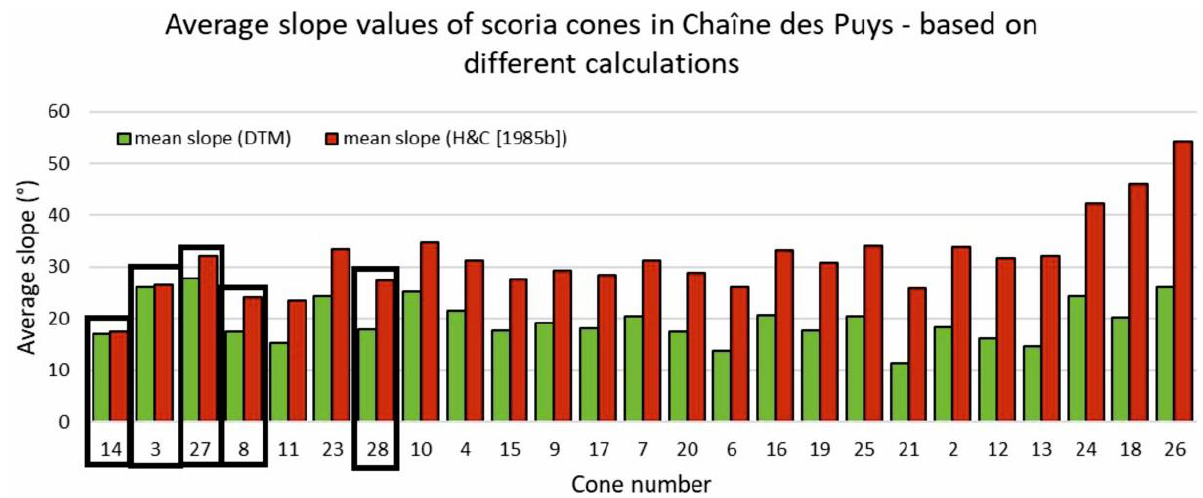
Figure 6. Difference in average slope calculations: according to H&C [35] (red) and based on DTM (green). The former (parameter-based) method obviously overestimates the average slopes, sometimes extremely.